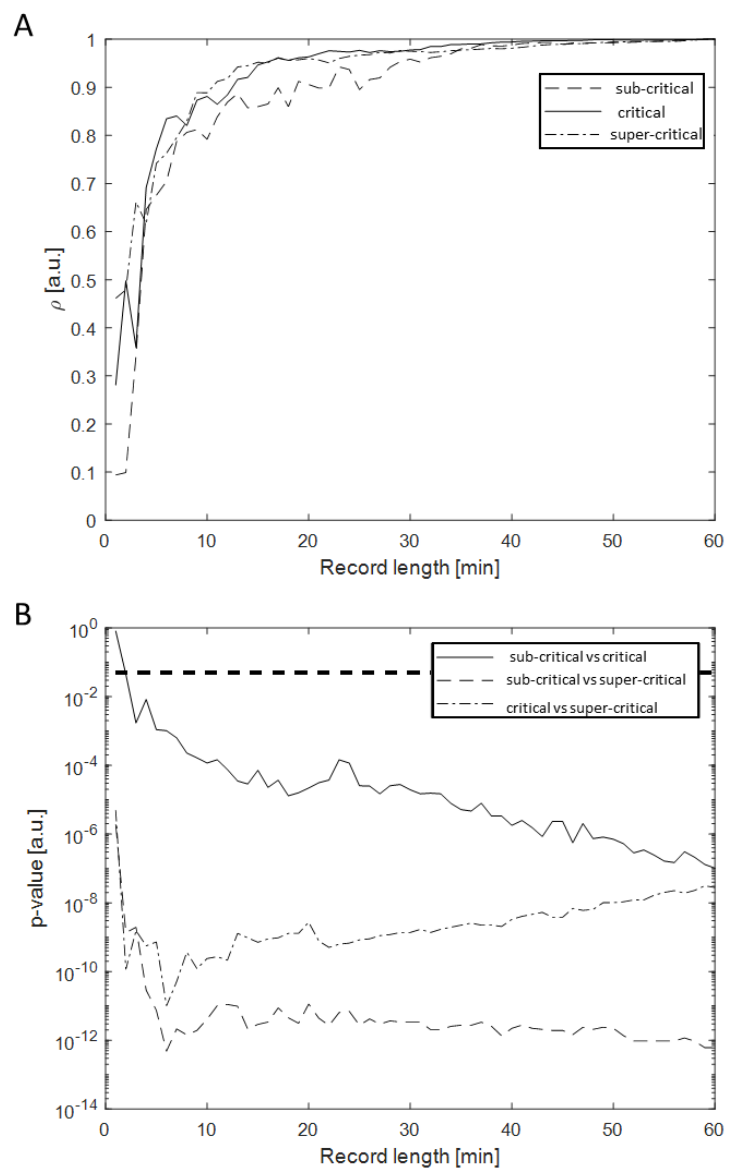
Figure A2. Same as Figure 3, but considering SampEn instead of ApEn. ( A ) Pearson correlation coefficient trend w.r.t. the recording time. The correlation is computed among the vector of SampEn values estimated from the record length reported in abscissa and the vector of SampEn values estimated from the full-length record (60 min). ( B ) Trend of p -value, as estimated by a pairwise Wilcoxon signed rank test followed by a Bonferroni correction, w.r.t. the sub-record length. The dashed horizontal line represents the confidence level of